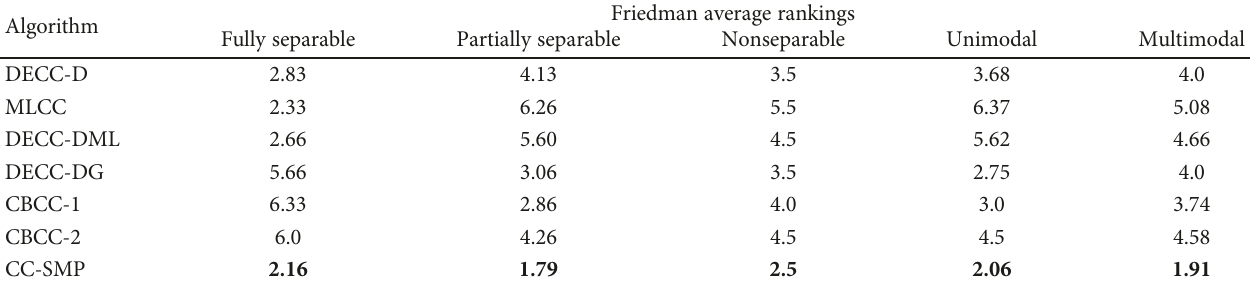
Table 5: Friedman average rankings.